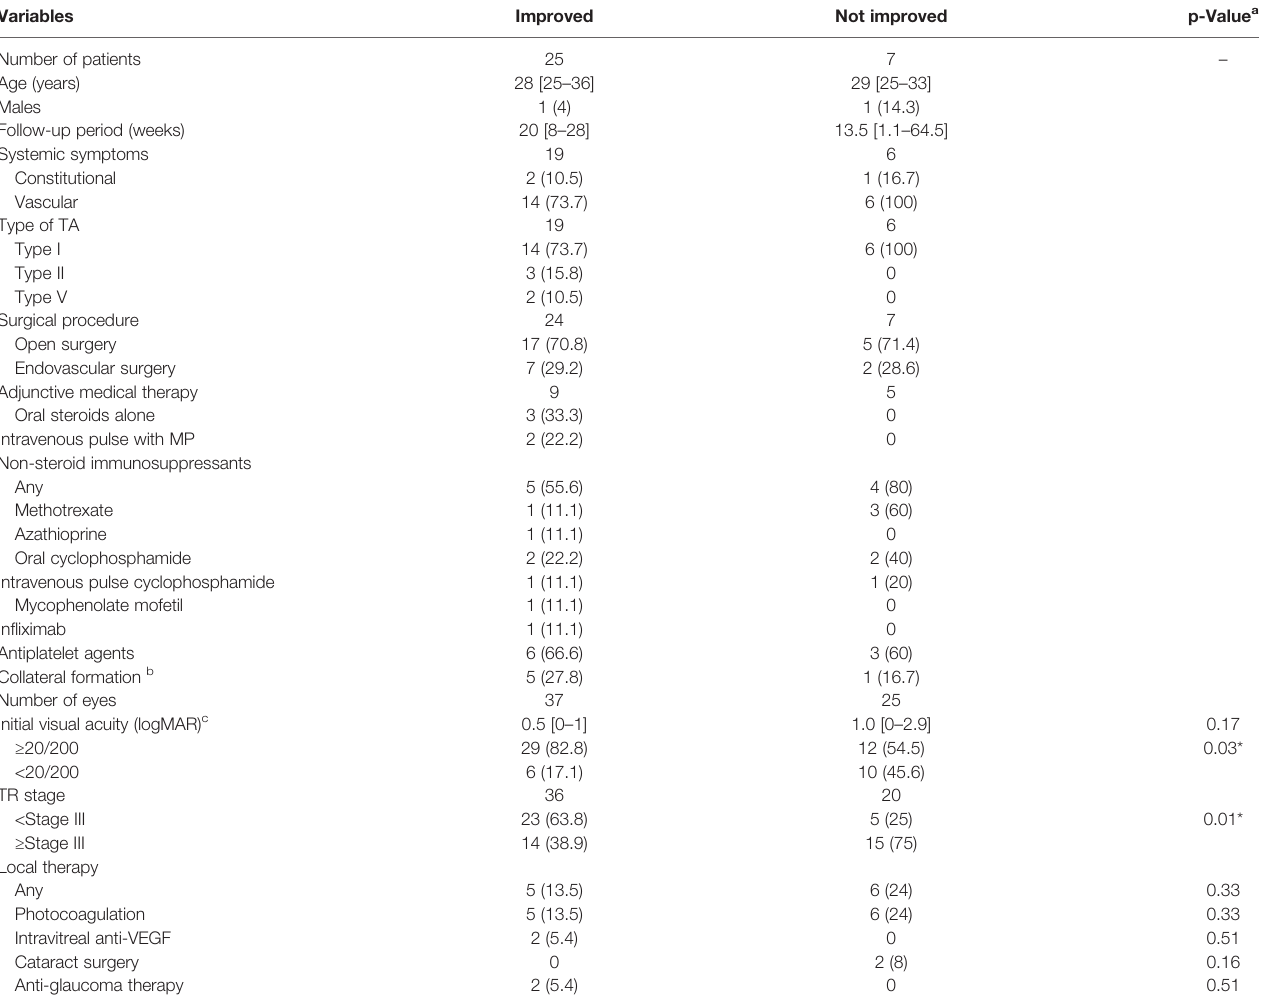
TABLE 3 | Comparison of TR patients with and without ocular improvement after surgical